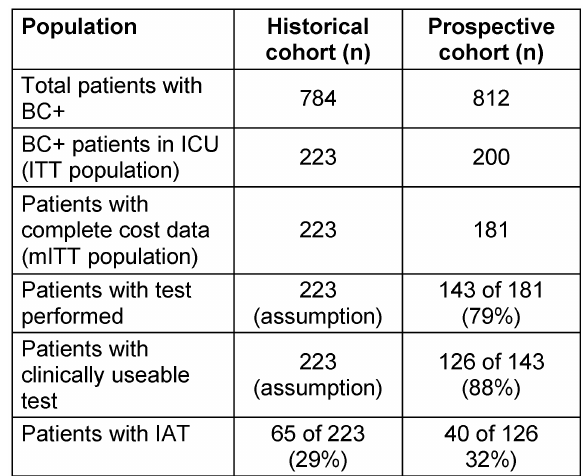
Table 2: Patient selection and assignment to analysis